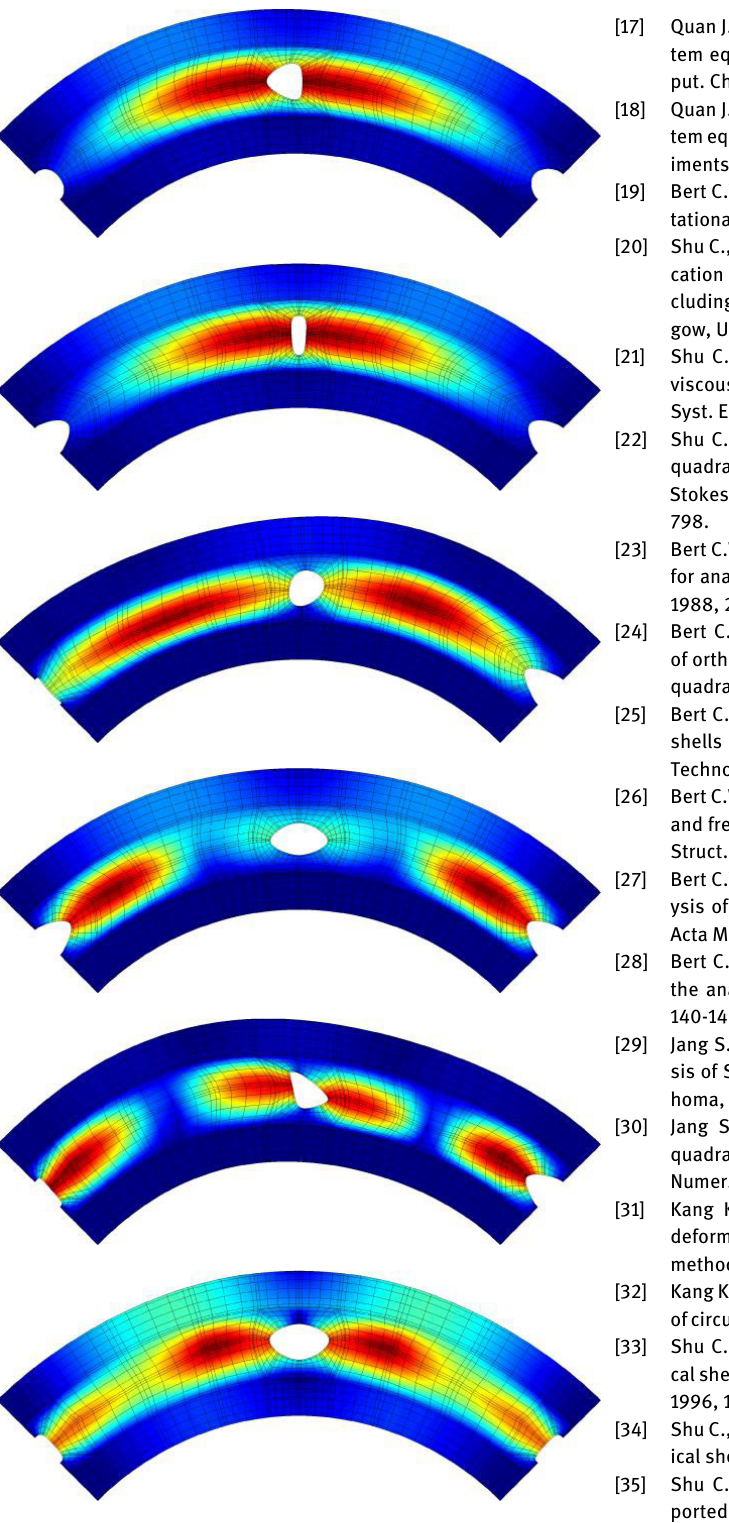
Figure 23: First six mode shapes of a composite arch with ratio E s / E c = 1000 using N = M = 7 grid per